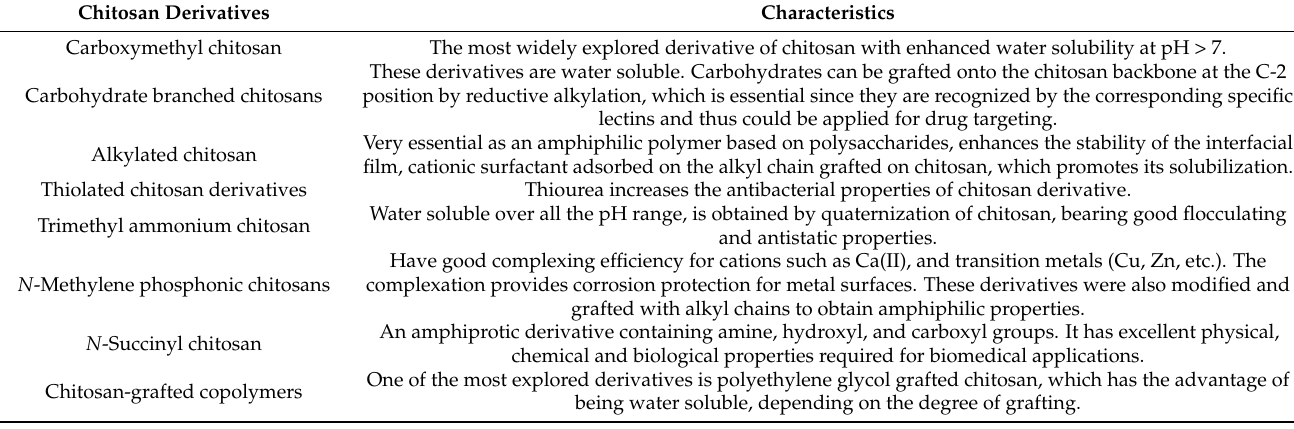
Table 3. Chitosan modifications for wound healing dressings reviewed in references [14,114]. Chitosan Derivatives